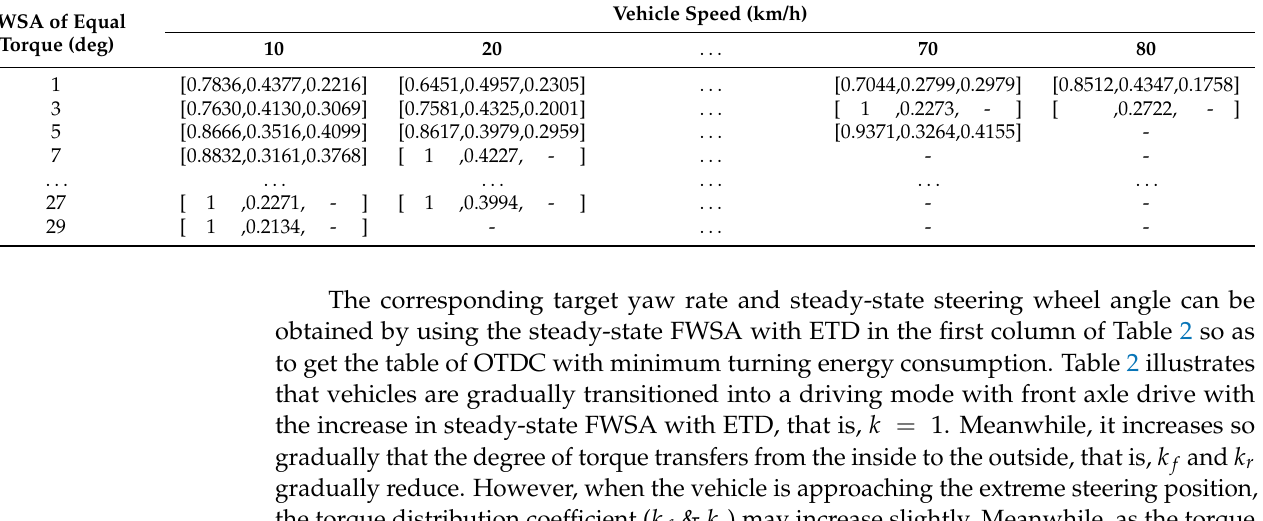
(cid:104) (cid:105) k , k f , k r